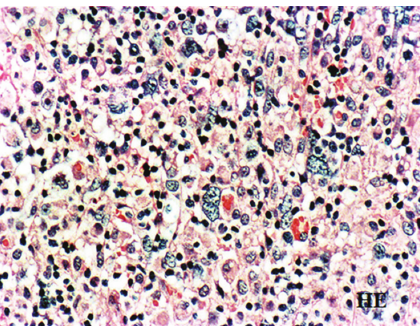
Figure 2: Histology of the cervical lymph node biopsy showing the infiltration of giant cells reminiscent of Reed-Sternberg cells and atypical large round cells with remarkable nucleoli in the background of lymphocytes, original magnification × 300. H&E